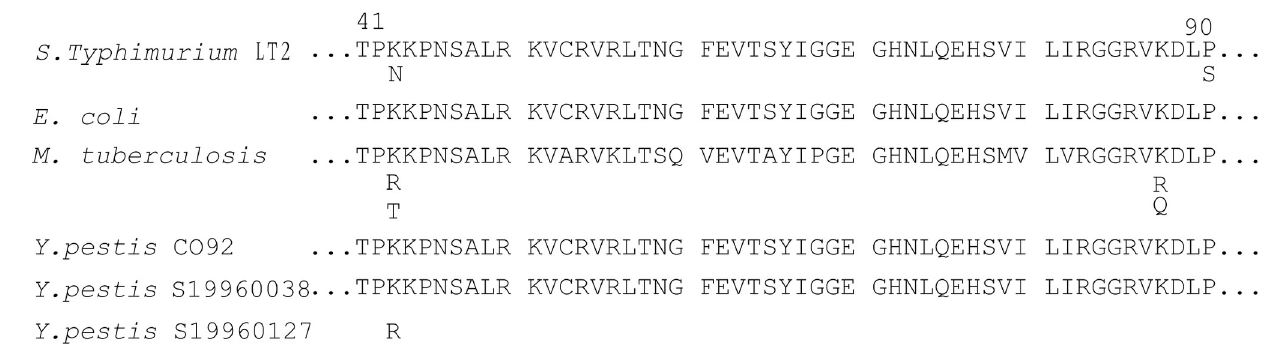
Fig 1. Sequence comparisons of RpsL protein. The relevant streptomycin resistance determinants in S19960127 compared with CO92 and a local susceptible isolate S19960038, as well as M . tuberculosis , E . coli , and S . Typhimurium . Each singly conferring streptomycin resistance are listed below the relevant positions. The numbering is based on reference sequences of the E . coli K-12 substrain MG1655 RpsL (accession number NP_417801). Amino acid substitutions in RpsL were observed at positions 43 in Y . pestis S19960127.